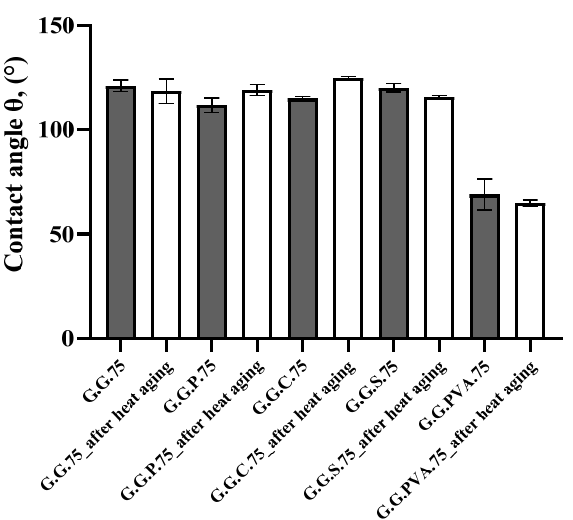
Figure 13. Comparison of the contact angles for samples before and after heat aging.